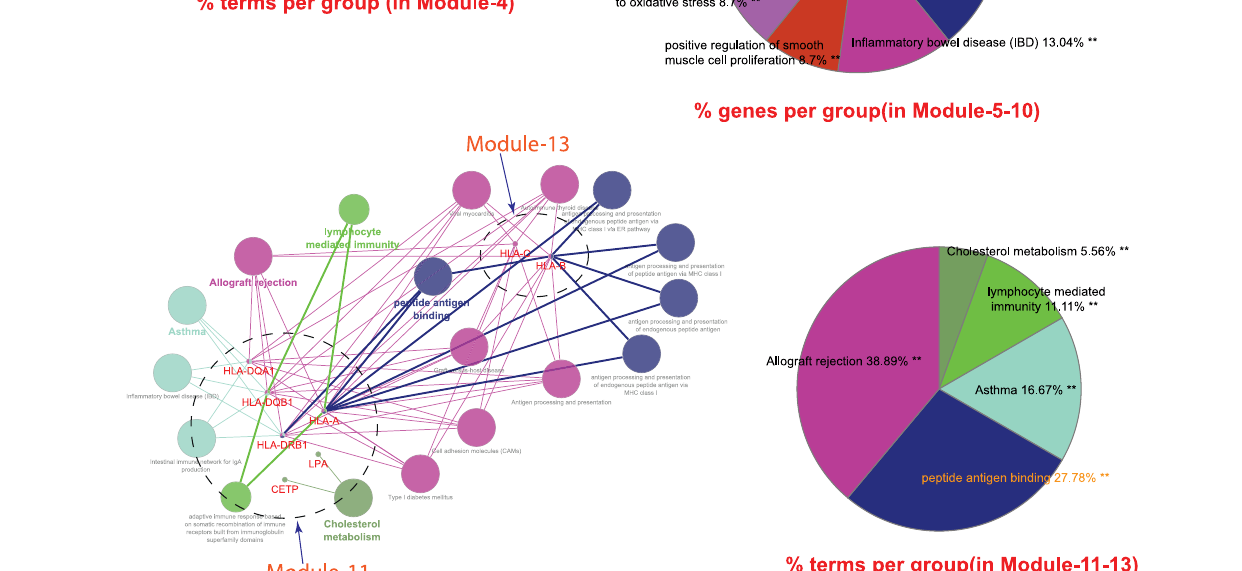
Frontiers in Pharmacology |